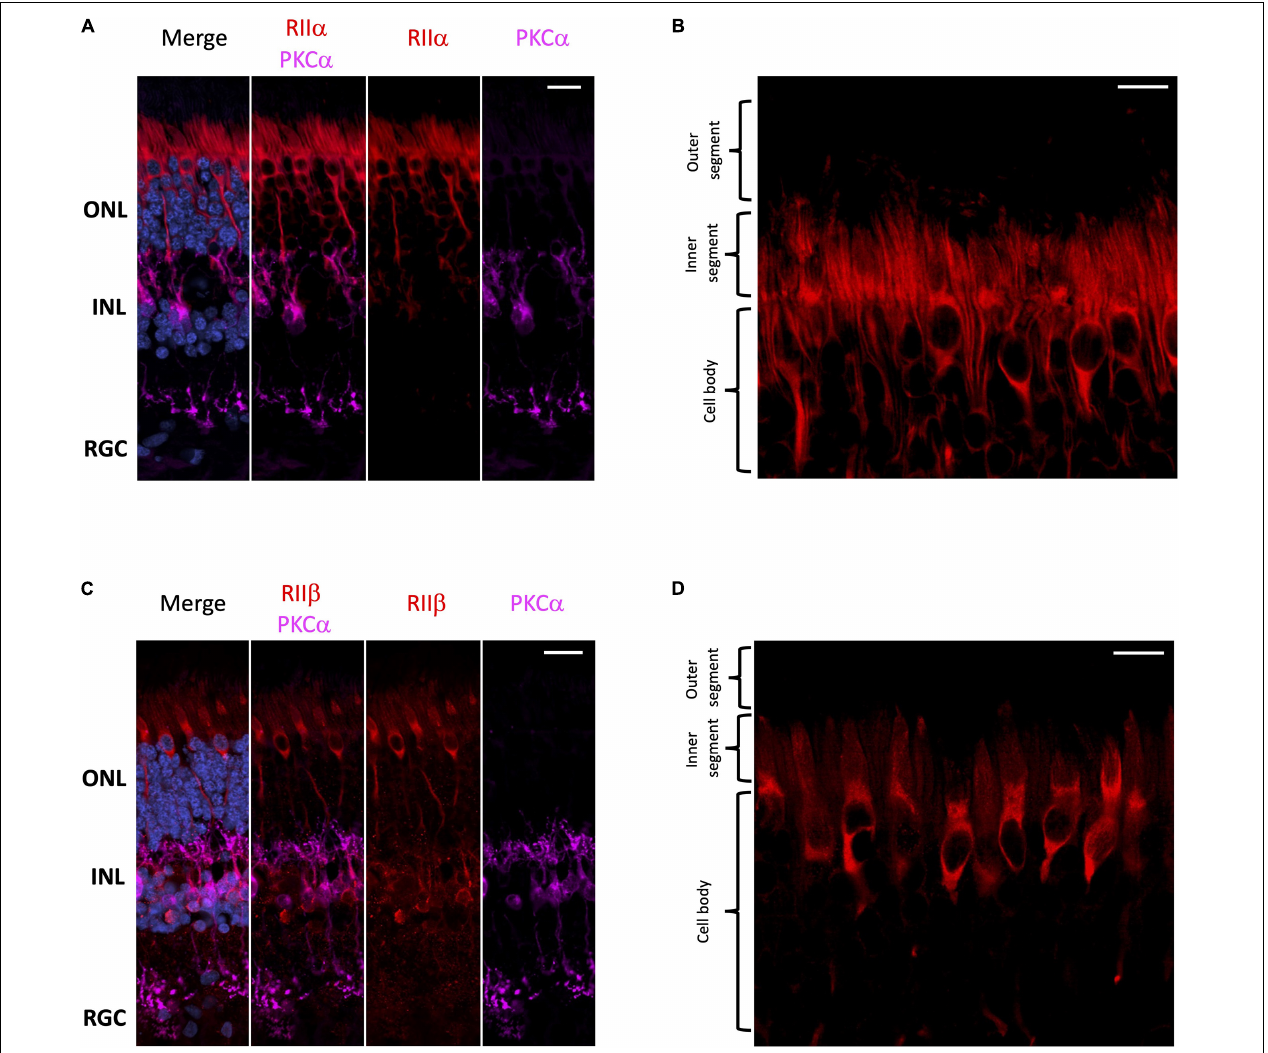
FIGURE 3 | RII α and RII β are differentially localized in human retina. (A–D) All sections were labeled with anti-PKC α antibodies in order to identify rod-bipolar cells (purple), which helped distinguish between the outer nuclear layer (ONL), inner nuclear layer (INL), and retinal ganglion cell layer (RGC). Nuclei in blue, scale bar = 20 µ m (A,C) , 10 µ m (B,D) . (A) RII α (red) is localized to cells in the ONL and INL, but not the RGC. (B) In photoreceptors, RII α (red) is generally localized to the cell body and axons of both cone and rod photoreceptor cells. (C) RII β (red) is localized to cells in the ONL and INL, but not the RGC. (D) In photoreceptors, RII